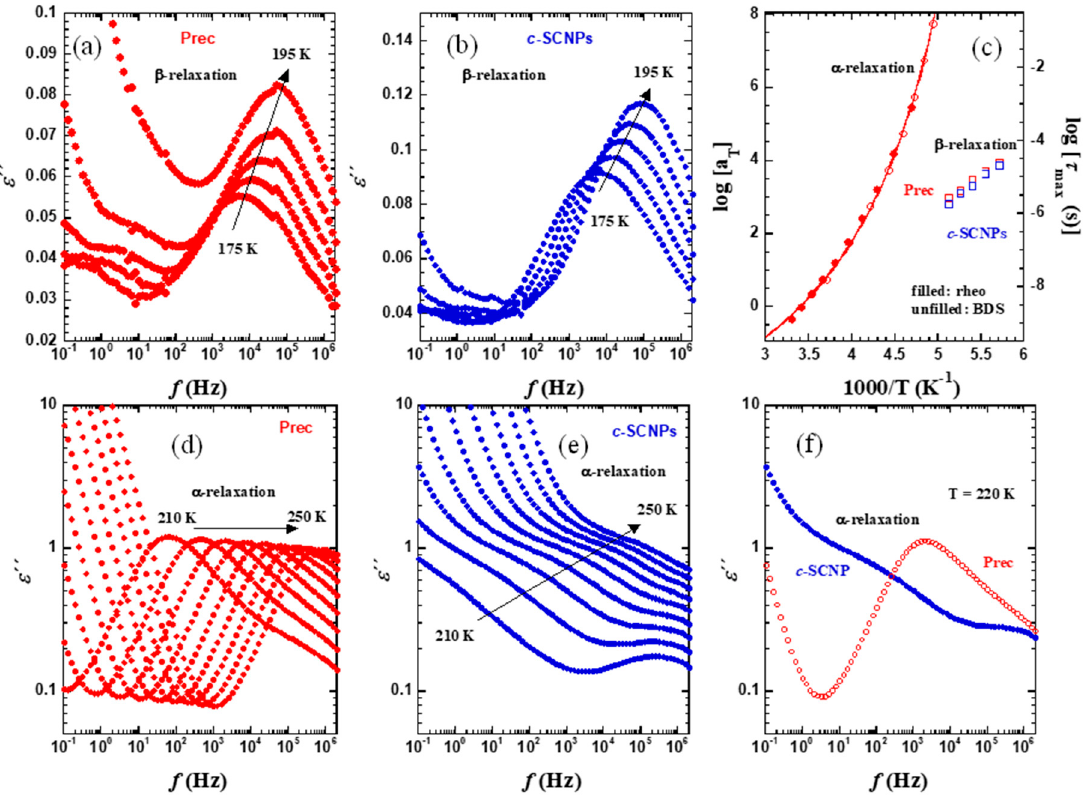
Figure 4. Isothermal plots of ε ´´ in the glassy state ( a , b ) and in the supercooled liquid state ( d , e ) for Prec sample ( a , d ) and c -SCNPs sample ( b , e ). The characteristic times obtained from the maxima of the loss peaks are represented in ( c ) ( β -relaxation: unfilled squares; α -relaxation: unfilled circles). For Prec sample, the rheological shift factors are also shown for comparison (filled circles). The solid line is the VFT fit of BDS Prec results. In ( f ), a direct comparison of the results from the two samples at T = 220 K is shown.